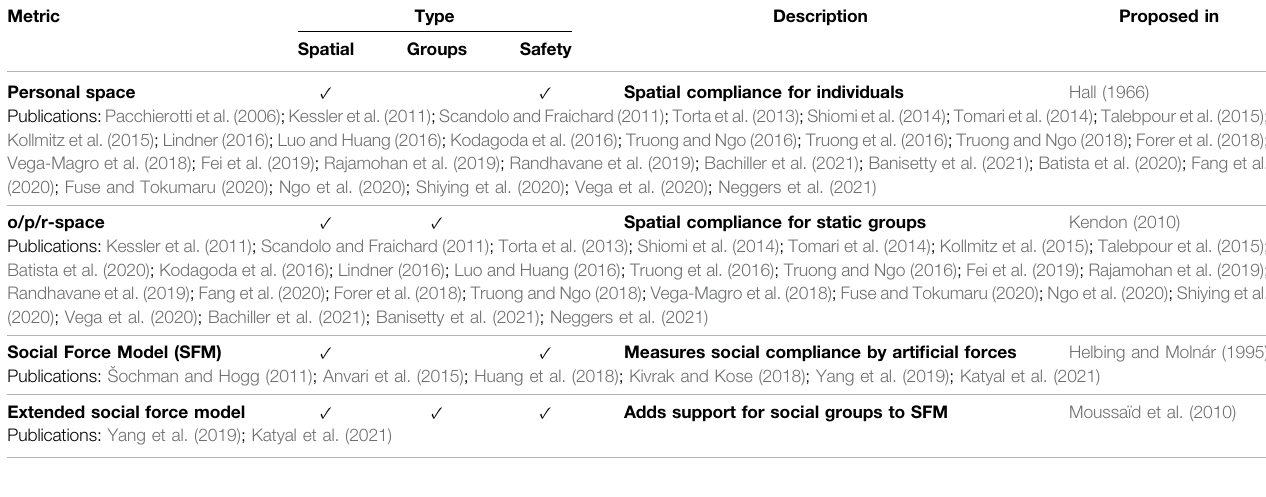
TABLE 6 | Evaluation metrics for human discomfort.